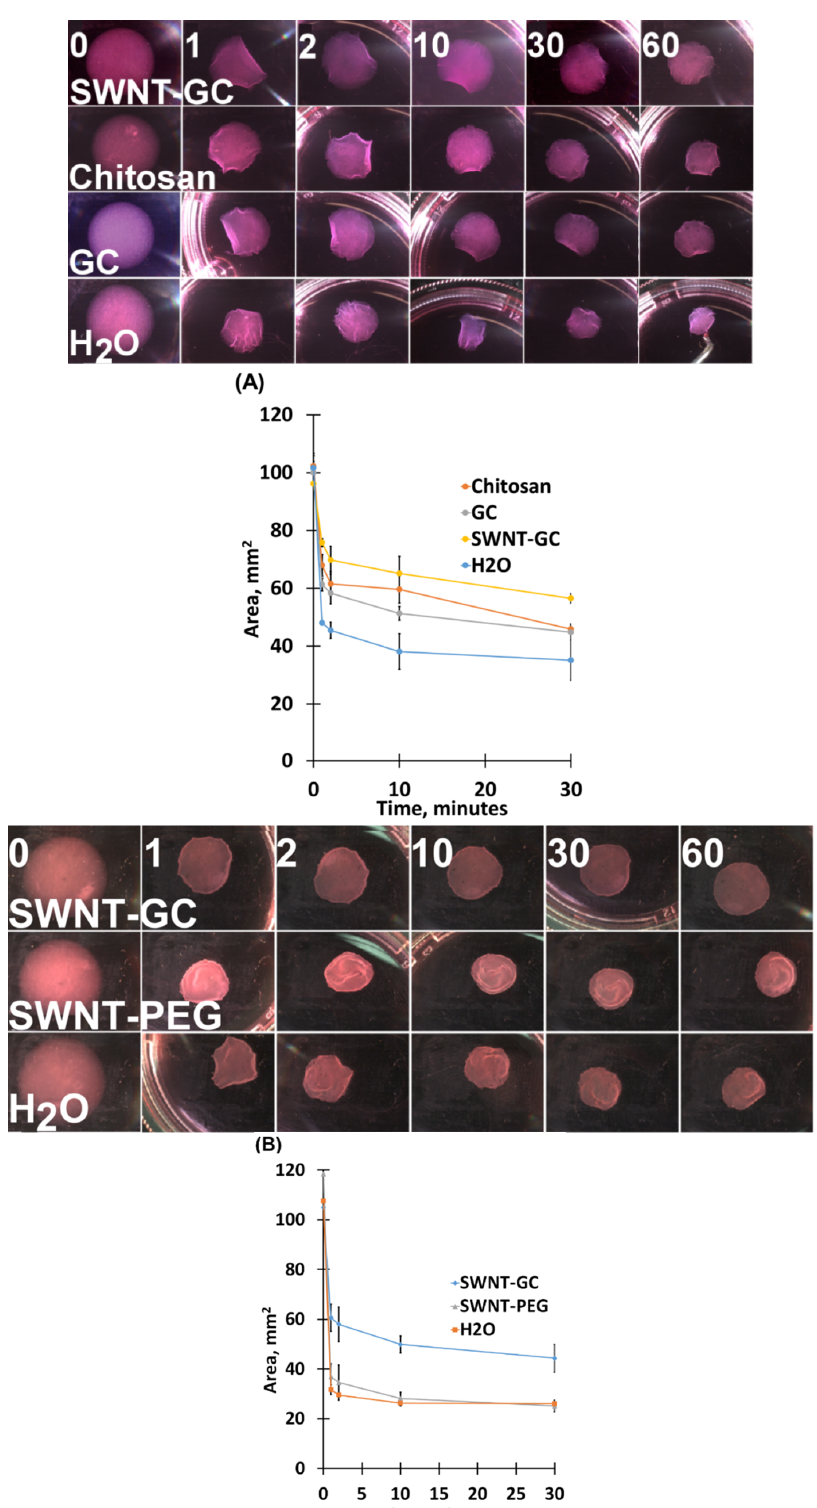
Figure 4. ( A ) Chitosan derivative-containing aFPCM exhibited less contraction compared to controls. Images of aFPCM diameter captured by camera and software showed that chitosan derivative-containing aFPCM, while anchored, had the same diameter as control aFPCM (top, left images), however once released, exhibited a larger diameter (reduced contraction) than control at the measured timepoints. Control means were SD than C and SWNT-GC means for 1-60 min. GC means were SD than control means only at 1, 10, and 60 min. ( B ) SWNT-PEG- but not SWNT-GC-incorporated aFPCM contracted similar to controls. Control means were SD than SWNT-GC means for 1–60 min. SWNT-PEG